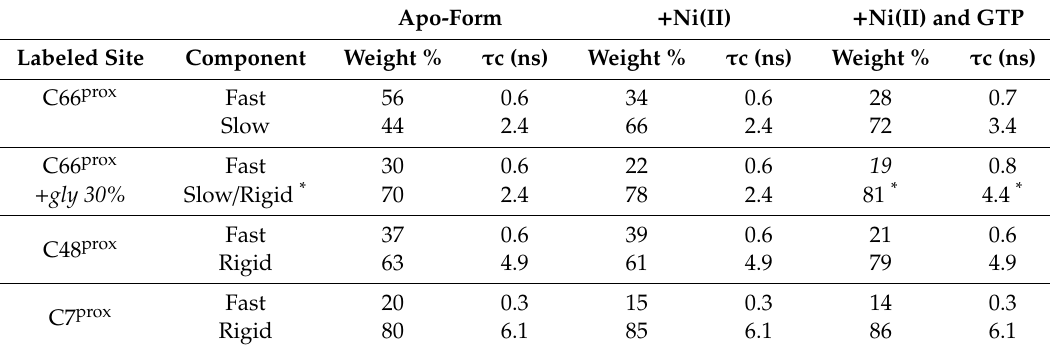
Table 2. Electron Paramagnetic Resonance (EPR) spectra simulation parameters: rotational correlation times ( τ c in ns) and proportion (%) of the simulated multi-components of the spectra of Hp UreG variants under various conditions. Apo-Form + Ni(II) + Ni(II) and